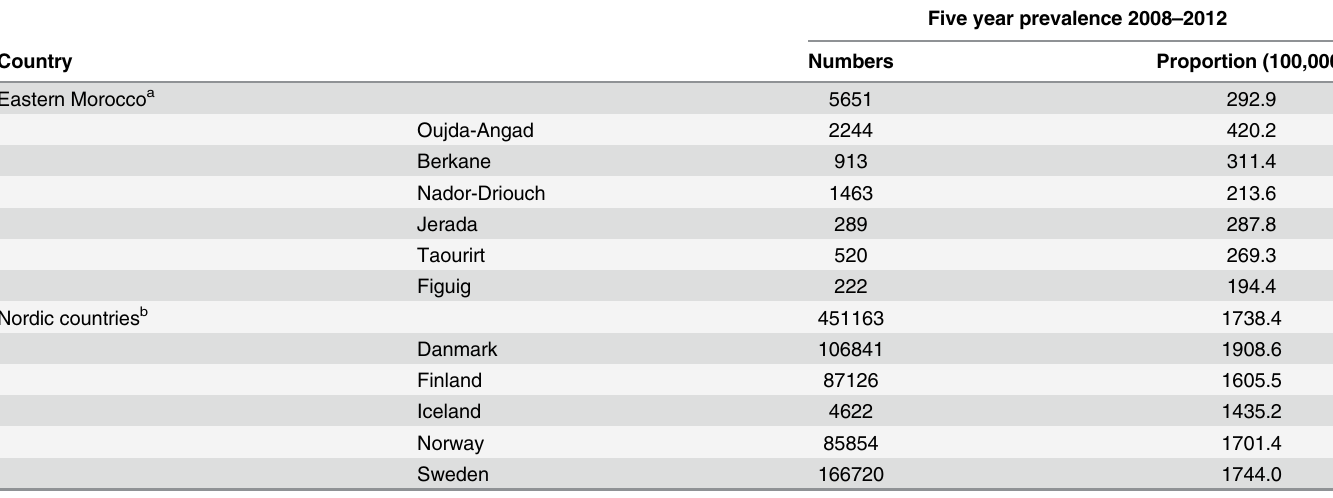
Table 4. Age-standardized five-year prevalence proportions for all cancers in area of Eastern Morocco as compared to other